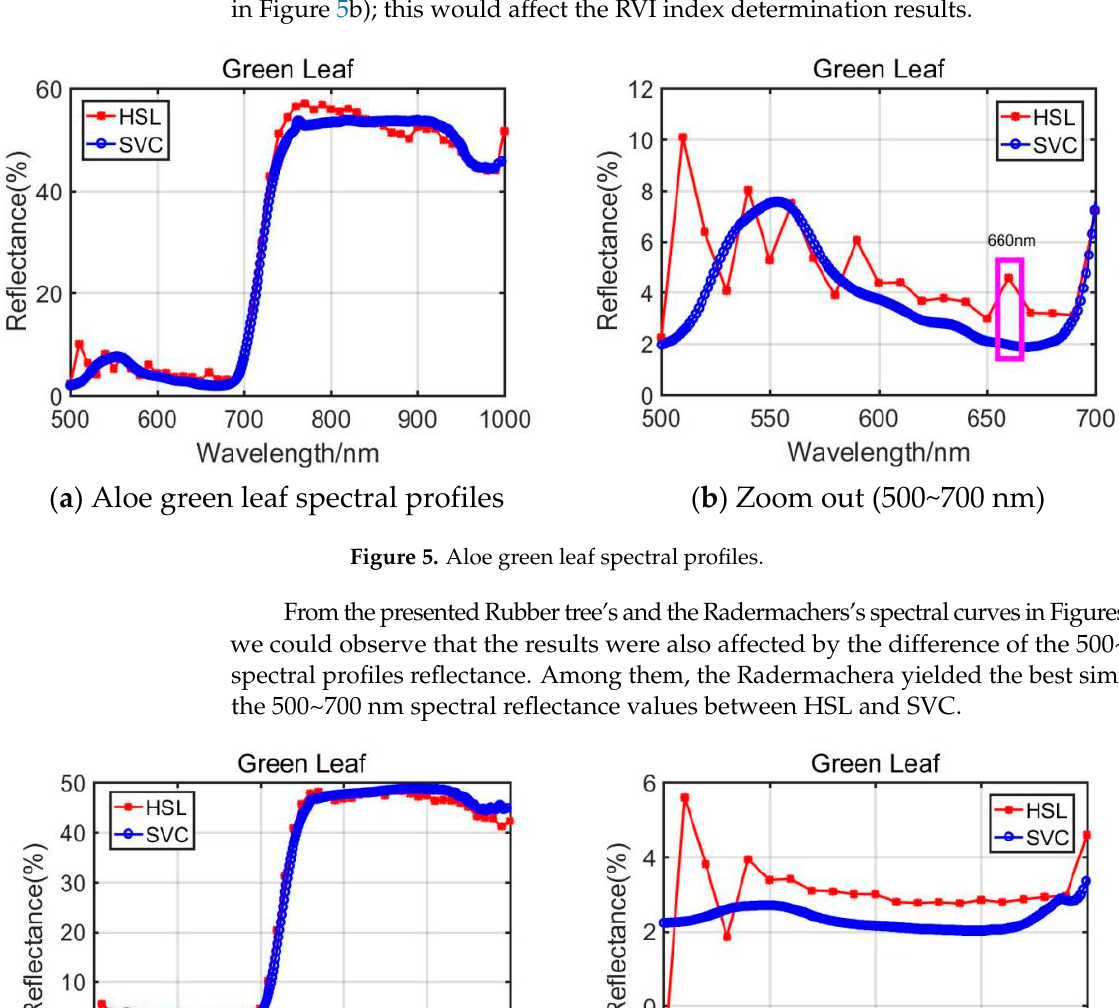
Figure 4. Dracaena green leaf spectral profiles.